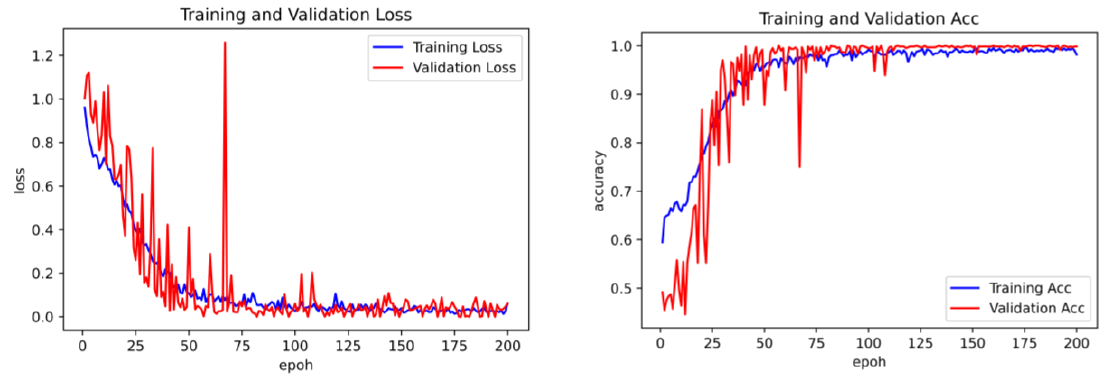
Figure 6. Training and validation loss using six participant